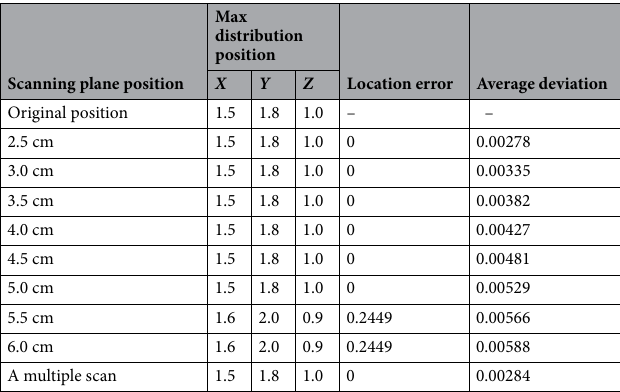
error represents the position difference of the maximum distribution. When the Z position of the sensor was 5.5 cm, the location error started to be nonzero. The calculated inverse distribution of the multiple scan did not seem to have a significant improvement compared to the inverse distribution for the smaller Z position such as Z = 2.5 or 3.0 cm. The scanning plane with larger Z position values did not help. The scanning plane with Z = 2.5 cm was the closest scanning plane